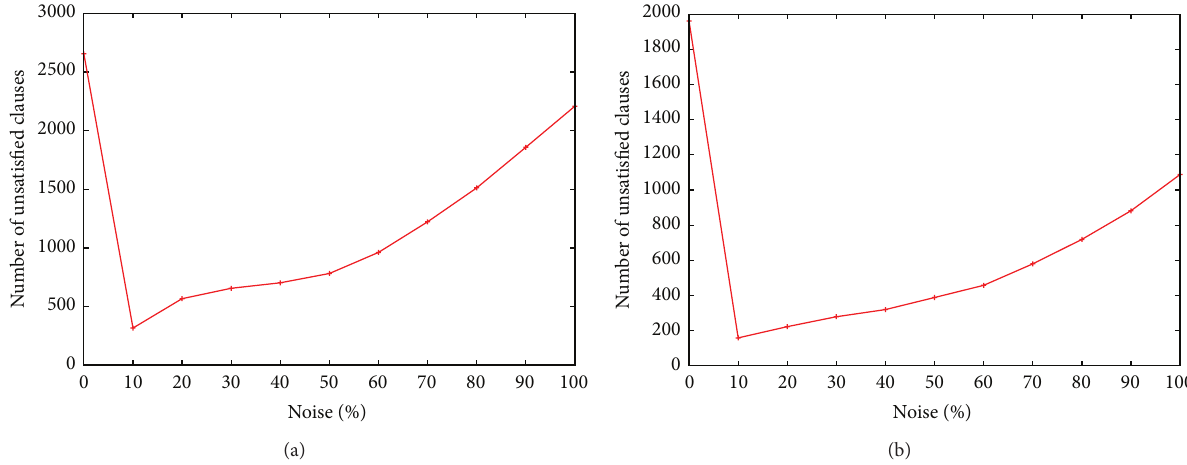
Figure 2: Noise probability versus number of unsatisfied clauses: (a) i2c-master1.dimacs.filtered.cnf: variables = 82429, clauses = 285987, (b) mem-ctrl-debug.dimacs.cnf: variables = 381721, clauses =